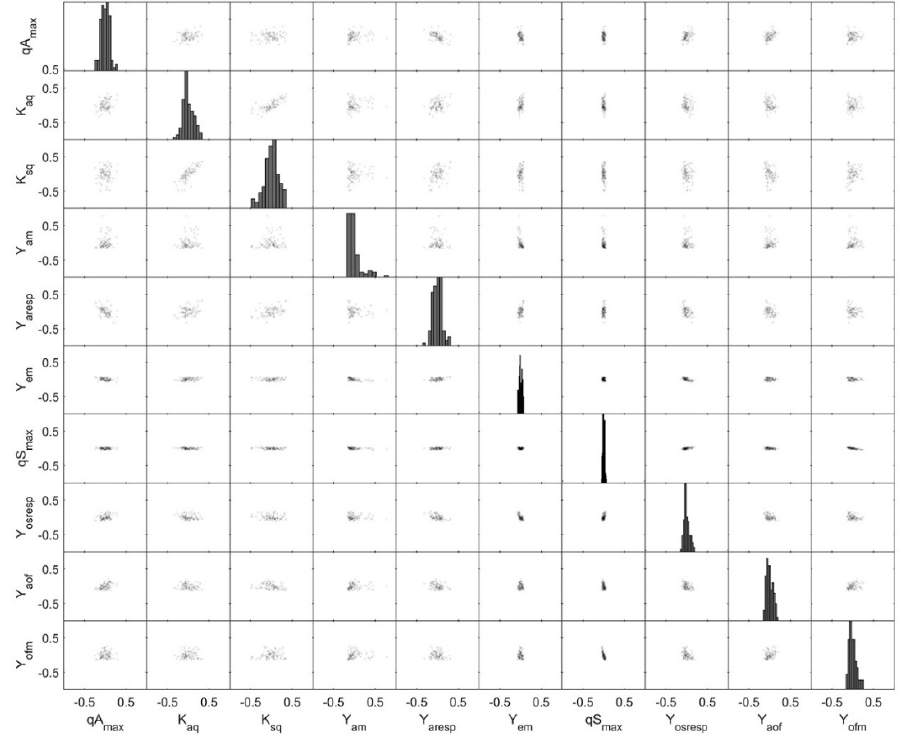
Figure 8. Monte Carlo parameter estimation: pair plots of the 500 best Monte Carlo parameter estimation results and with the identifiable parameter set based on the dataset for E. coli BW25113 ∆ glcB during the last modelling cycle. Monte Carlo simulations were carried out with σ = 0.15 for biomass, glucose and acetate and with σ = 0.05 for DOT.